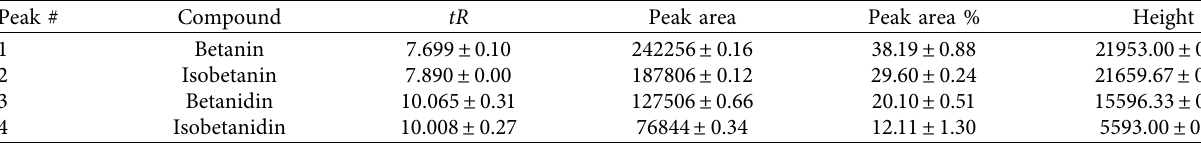
The results are shown as the mean values of three replicates ± SD. Table 4: Betanin content estimates for the B. vulgaris L. sample.